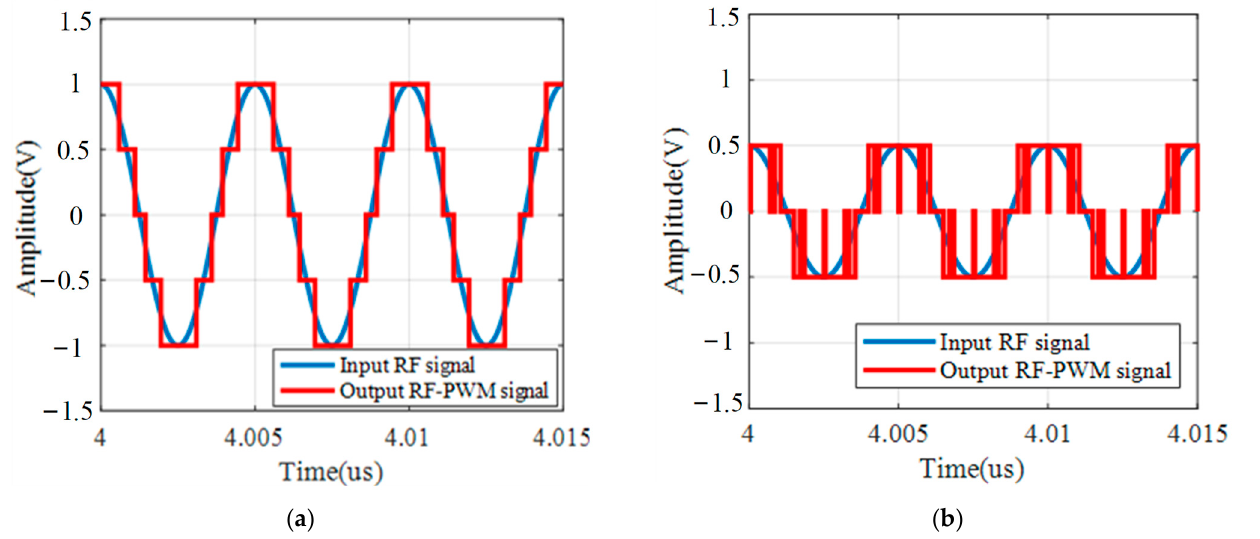
Figure 6. Waveforms of the RF input and output signals under SIII when ( a ) a ( t ) = 1 ( b ) a ( t ) = 0.5, with the input single-tone signal at a 200 MHz carrier.